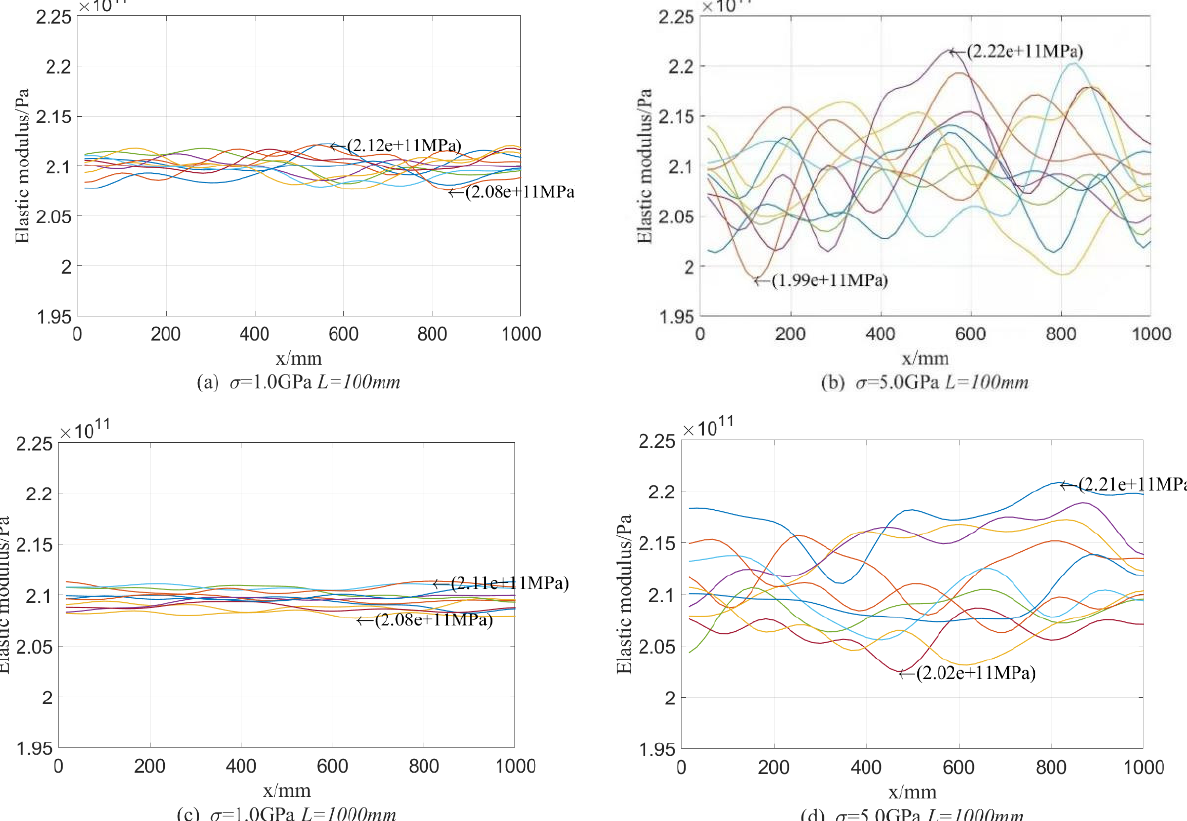
Figure 4. Random field of Young’s modulus E in the beam.